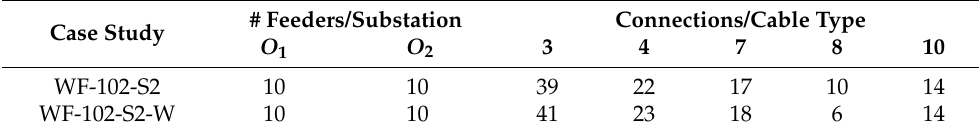
Table 3. Optimal solution cable type: WF-102-S2 and WF-102-S2-W wind